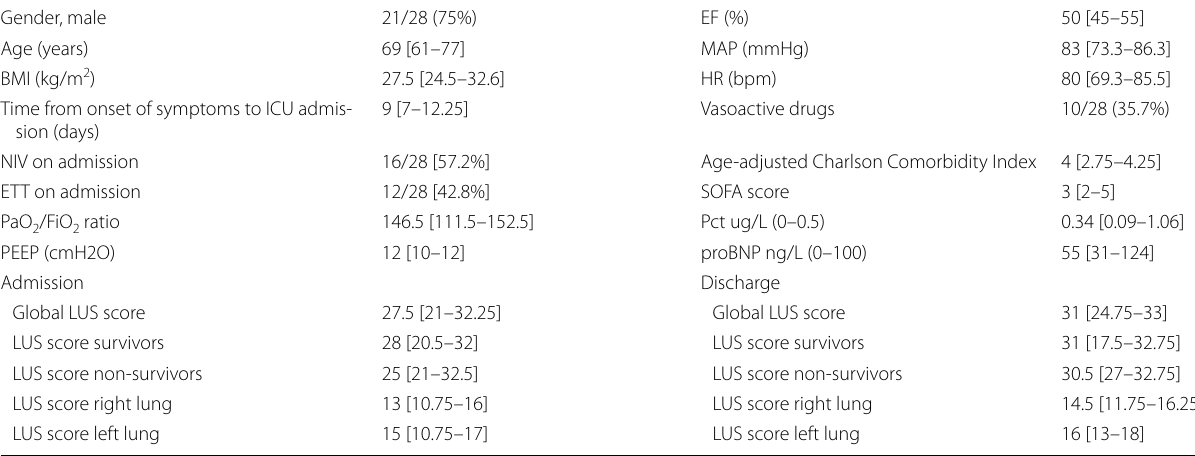
Variables are expressed as median and interquartile range or percentage NIV non-invasive ventilation, ETT endotracheal tube, EF ejection fraction, Pct procalcitonin, pro-BNP brain natriuretic peptide, SOFA sequential organ failure assessment, MAP mean arterial pressure, HR heart rate, BMI body mass index